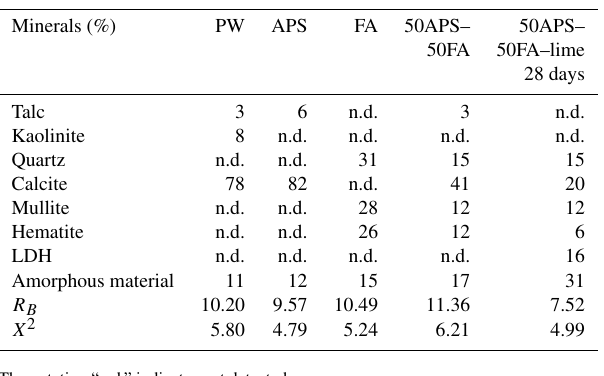
Table 3. Mineralogical composition by XRD of products from coal mining (PW, APS, FA, 50APS–50FA and after 28 days of reaction in the 50APS–50FA–lime system).